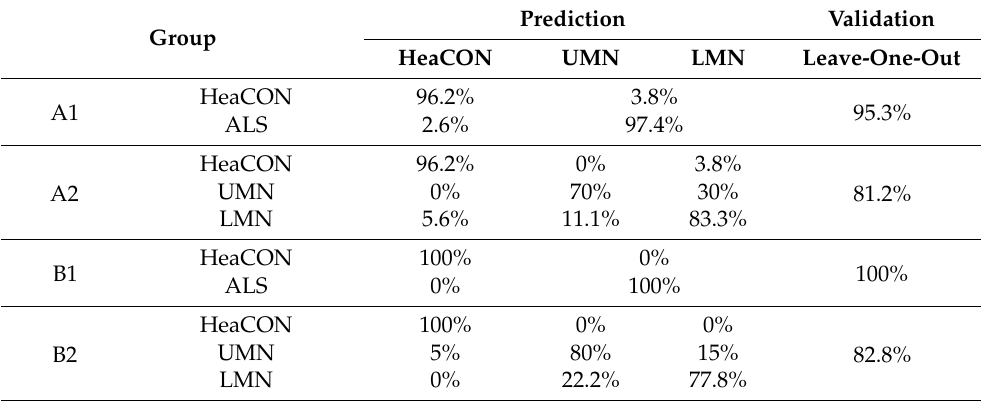
Table 4. Discriminant analyses. Predicted group membership and leave-one-out cross-validation for discriminant analyses involving either the left precentral gyrus, inferior temporal gyrus, and temporal pole (A) or 34 ROIs from the left hemisphere using stepwise selection (B). Discriminant